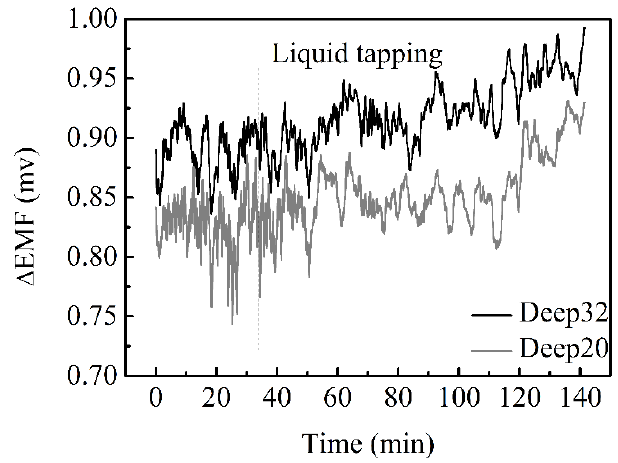
Figure 14. EMF signals at different depth in the same location.